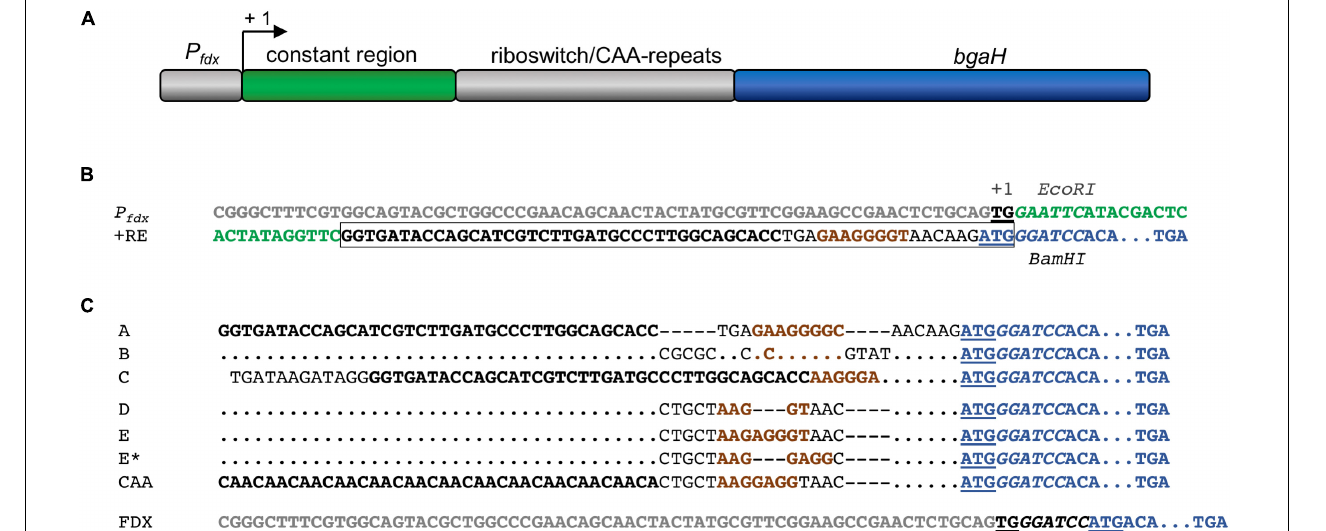
FIGURE 2 | P fdx promoter and synthetic 5 (cid:48) UTR to study theophylline-dependent bgaH translation in Hfx. volcanii . (A) Schematic representation of the P fdx - riboswitch- bgaH fragments. A constant region and the respective riboswitch (or CAA repeat) were inserted between the P fdx promoter and the bgaH reading frame. The transcription start site is marked +1. (B) DNA sequences of P fdx and riboswitch E. The sequence of P fdx is given in gray and the constant region of the 5 (cid:48) UTR is marked in green. The transcriptional start (TG) is bold and underlined and the ATG start of the bgaH reading frame in blue and underlined. The theophylline aptamer is shown in bold, and the bacterial SD sequence in riboswitch E is highlighted in brown. The complete riboswitch E is boxed. The recognition sequences of Eco RI and Bam HI surrounding the constant region and the riboswitch are in italics . The open reading frame of bgaH is highlighted in blue. (C) DNA sequence of the fusion of the respective riboswitch sequences to the open reading frame of bgaH . The aptamer domain (or CAA-repeats) are highlighted in bold and the bacterial SD sequence is shown in brown. The ATG start is underlined and the Bam HI-site in italics , and the open reading frame of bgaH is highlighted in blue. Dots mark the same nucleotides as shown in the riboswitch A sequence. Dashes indicate gaps in the sequence. For the location of the haloarchaeal SD sequences in these sequences compare Table 1 . In the case of plasmid pFDXJB20 (FDX), the P fdx promoter sequence is highlighted in gray, while the ATG start is underlined and the BamHI is shown in italics